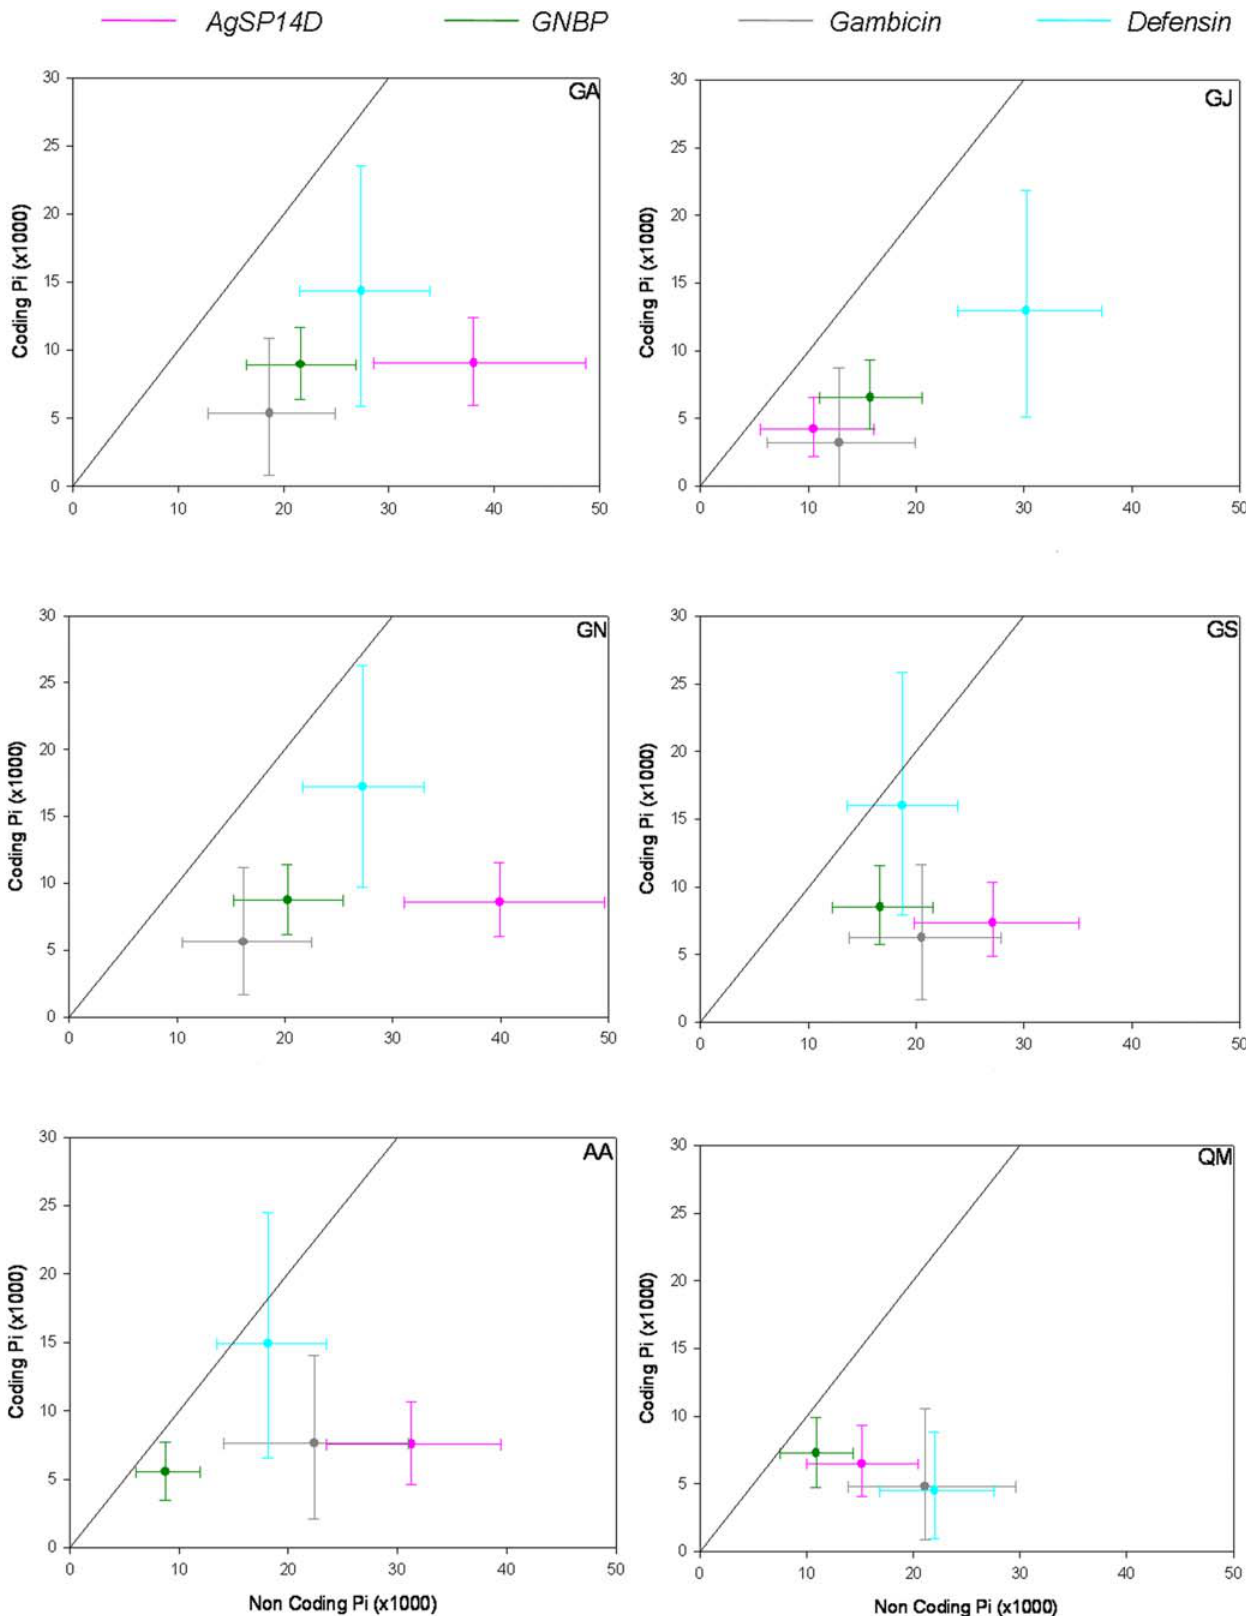
Figure 3. Diversity ( p ) and 95% CI in coding and NC regions in each population. Diagonal lines mark equal diversity of coding and NC regions. GA, GJ, GN, and GS denote An. gambiae populations from western and eastern Kenya, Nigeria and Senegal, respectively. AA and and QM denote An. arabiensis and An. quadriannulatus respectively.